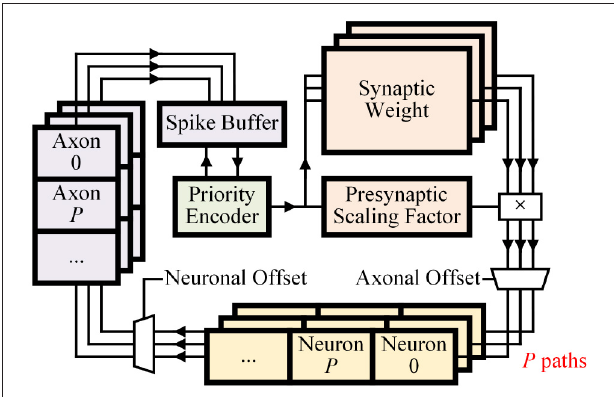
FIGURE 7 | Dataflow of the design with parallelization number P . Learner module is omitted for